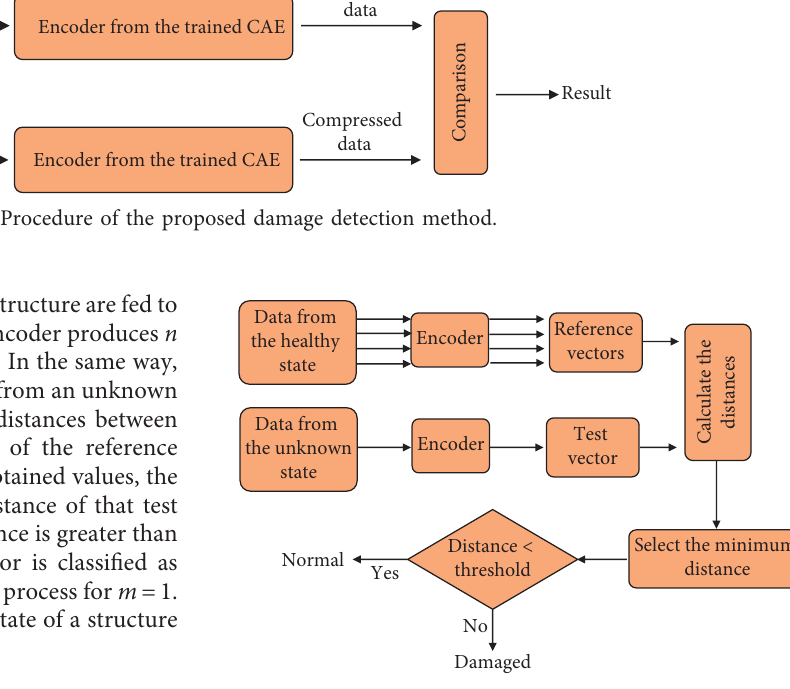
Figure 4: Classification of the vector obtained from a 2D matrix from an unknown state of the structure ( m �